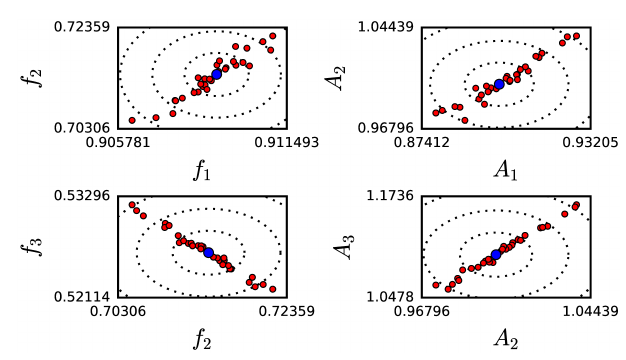
Fig. 4.— Model 19 frequencies ( f 1 ,f 2 ,f 3 ) and amplitudes ( A 1 ,A 2 ,A 3 ). Original model results are denoted with larger blue circles and bootstrap results with smaller red circles. Dotted lines denote one, two and three sigma error limits. TABLE 2 Simulated model. Column 1 gives parameters of Eq. 20. Column 2 gives simulated values. Columns 3 and 4 give detected values for models 19 and 20.